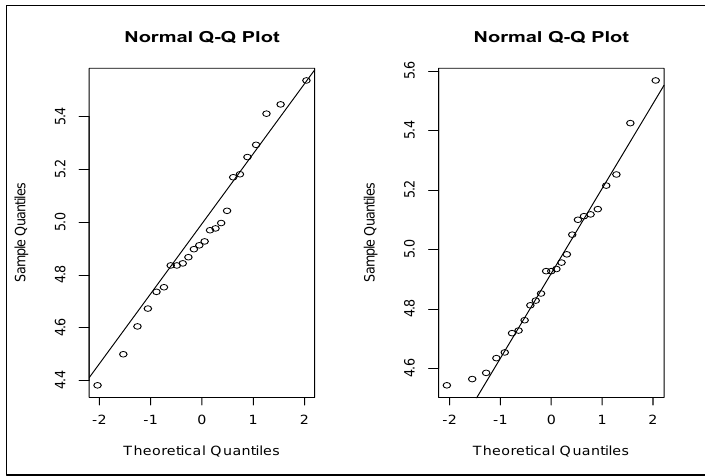
Figure 3. The normal QQ-plots of log-PM10 data of the Nan and Chiang Mai